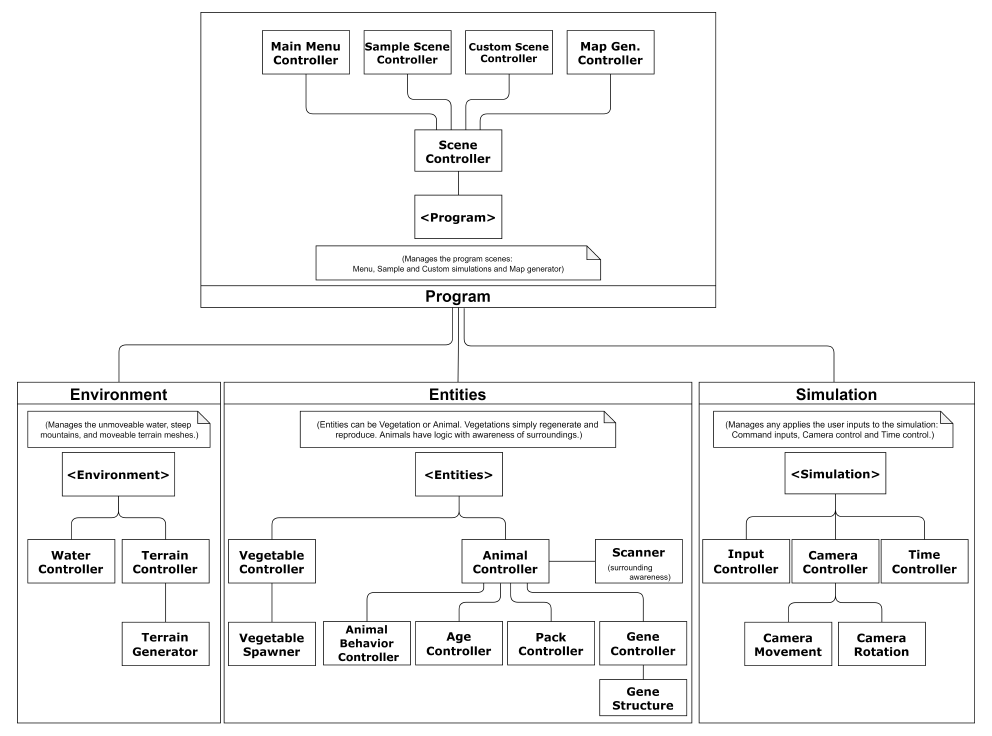
Figure 1. The framework is divided into four main components with multiple controllers which control the different parts of the program.